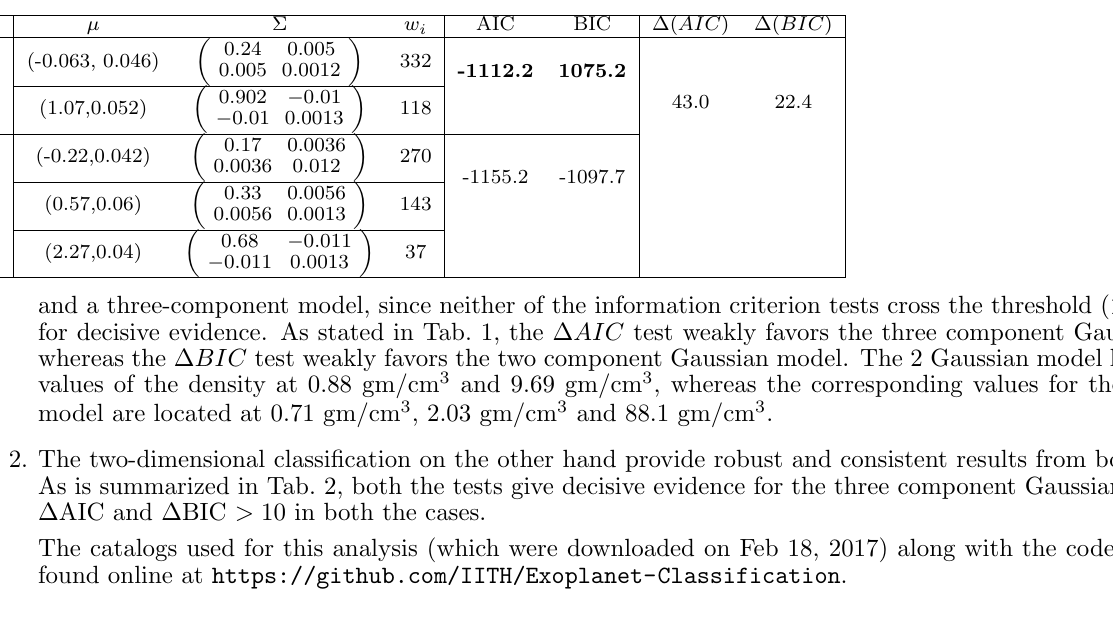
TABLE 2 Results from model comparison for 2D classification of exoplanets using logarithm of the density and ESI, along with results from information theoretic criterion. The explanation for the first two columns is same as in Tab. 1. The third column denotes the covariance matrix. Other columns are same as in Table 1. For this case, both AIC and BIC point to decisive evidence for three